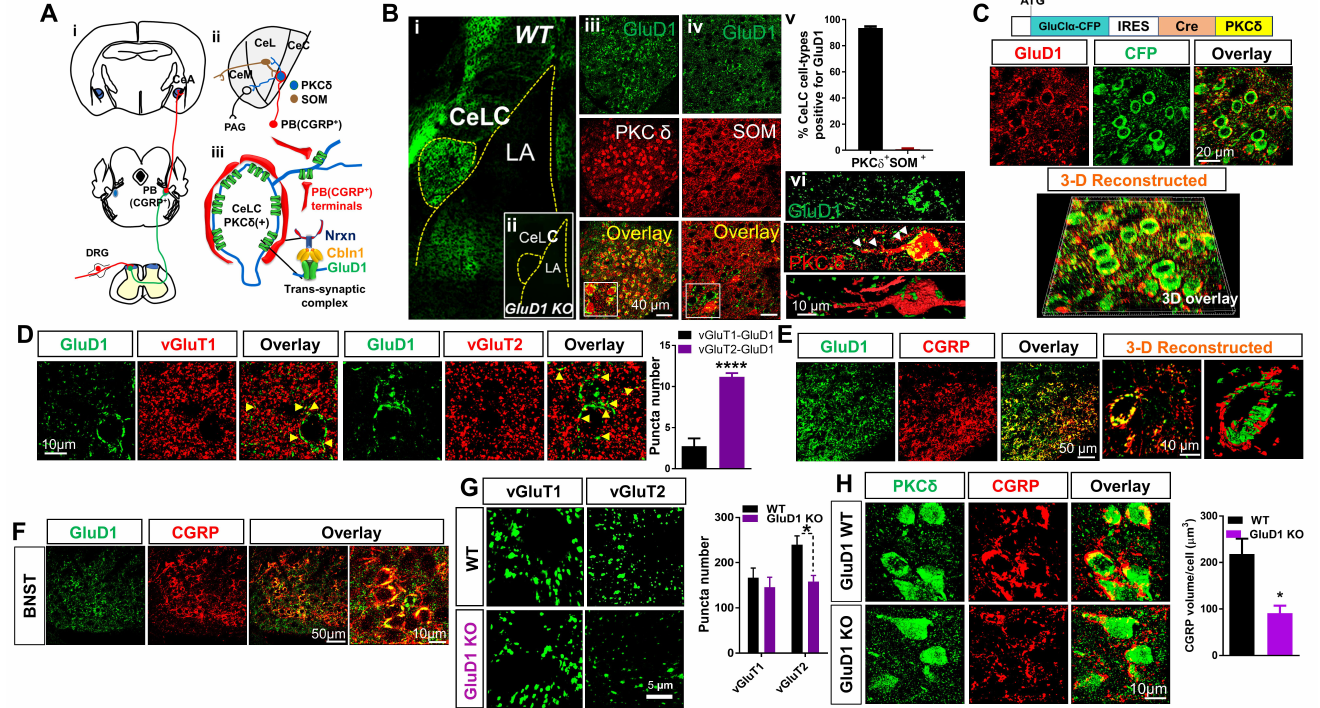
Figure 1. Glutamate receptor delta 1 (GluD1) serves as a critical regulator at parabrachio-amygdalar synapses. ( A ) Schematic representation of parabrachio-amygdalar pathway. (i) Nociceptive information from periphery reaches laminae I and V spinal dorsal horn neurons. Ascending projections transmit nociceptive information via lateral parabrachial nucleus (PB) to the central amygdala (CeA). (ii and iii) Lateral and capsular divisions of the CeA (CeLC) receive glutamatergic inputs from PB-CGRP + terminals. GluD1 is localized postsynaptically and Neurexin 1 (Nrxn) is the presynaptic partner of the intermediate protein Cbln1. ( B ) (i) Immunohistochemical analysis reveals enriched expression of GluD1 in CeLC. (ii) No labeling in GluD1 KO demonstrates antibody specificity. (iii) GluD1 shows perisomatic and punctate labeling on PKC δ + neurons. (iv) Negligible co-labeling with SOM + neurons. (v) Quantification of GluD1 colocalization in both neuronal populations reveals 93.49% ± 1.104% were PKC δ + , whereas only 0.788% ± 0.572% were SOM + ( n = 5 mice). (vi) The 3D reconstruction of GluD1 puncta on PKC δ + neurons. ( C ) GluD1 localization to PKC δ + neurons using the PKC δ -CFP-Cre reporter mouse line. ( D ) Higher colocalization (yellow arrows) of GluD1 with PB marker vGluT2 vs. BLA marker vGluT1 (vGluT1-GluD1 ( n = 5 mice): 2.74 ± 0.93; vGluT2-GluD1 ( n = 5 mice): 11.16 ± 0.48, **** p < 0.0001, two-tailed unpaired t-test). ( E ) GluD1 is postsynaptic to CGRP terminals. Confocal analysis and 3D reconstruction reveal close apposition of GluD1 with CGRP. ( F ) GluD1 and CGRP show colocalization in BNST. Immunohistochemistry for GluD1 and CGRP in BNST demonstrate that CGRP ensheathes perisomatic GluD1 with a basket-like structure, similar to the pattern observed in CeLC. ( G ) Selective reduction in vGluT2 puncta in CeLC in GluD1 KO mice (Two-way ANOVA, genotype F (1, 12) = 4.774, p = 0.022, vGluT1: WT vs. GluD1 KO: 166.750 ± 21.379 vs. 145.5 ± 22.29; vGluT2: WT vs. GluD1 KO: 239 ± 19.759 vs. 158.25 ± 13.665, Bonferroni’s multiple comparisons test, * p = 0.025, n = 4 mice per group). ( H ) GluD1 deletion leads to significant reduction in CGRP projection in CeLC. Immunohistochemistry for CGRP in WT and GluD1 KO exhibit significant reduction in CGRP in CeLC, suggesting an impairment in PB inputs. (WT ( n = 5 mice) vs. GluD1 KO ( n = 4 mice): 218.4 ± 33.0 vs.